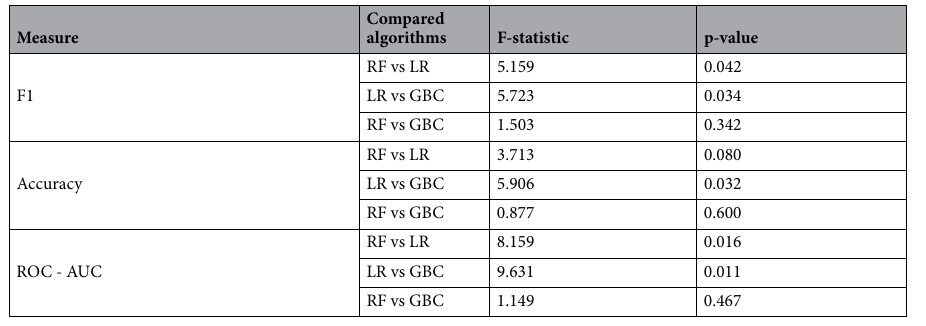
Table 3. F test results.